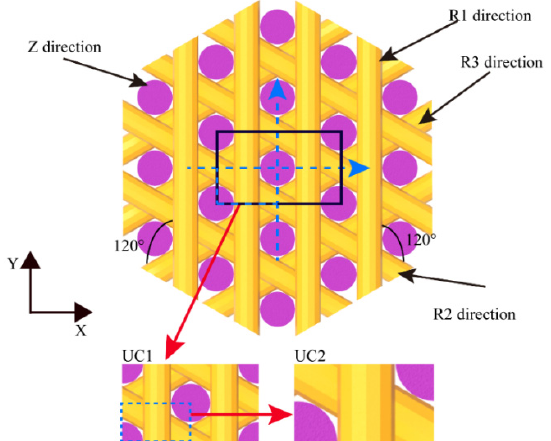
Figure 2. The formulation of UC1 and UC2.